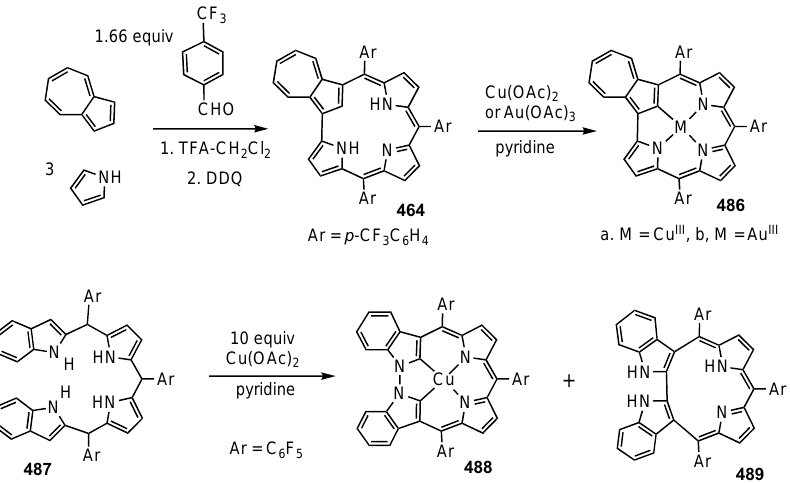
Scheme 74. Copper(III) and gold(III) complexes of carbacorrole analogues. Dicarbacorroles with a biphenyl unit or a phenanthrene moiety have been reported [306-308]. A bilane-like intermediate 490 incorporating a biphenyl unit was cyclized with pentafluorobenzaldehyde and BF 3 ·Et 2 O and, following oxidation with DDQ, dibenzicor- role 491 was obtained in 10% yield (Scheme 75) [306]. The X-ray crystal structure of 491